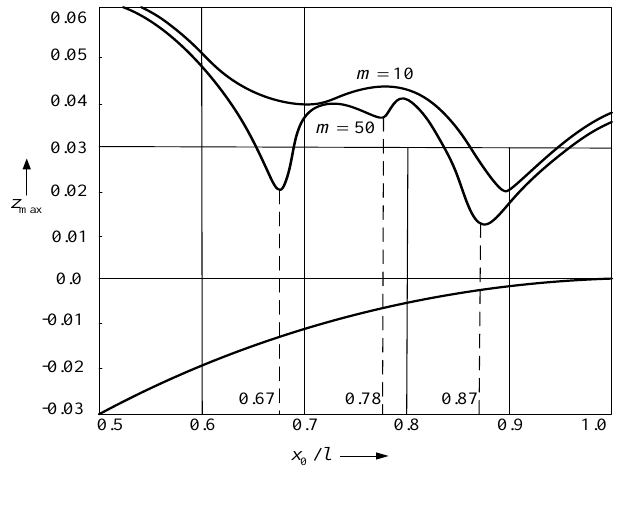
Figure 4. Dependence of dimensionless rebound amplitude of the microstructure lyz / maxmax